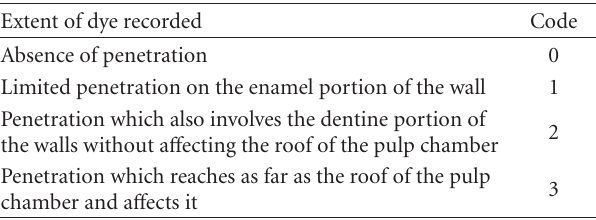
The steps (b), (c), (d), (e), and (f) were the same as de- scribed for the groups 1A, 2A, 1B, and 2B.